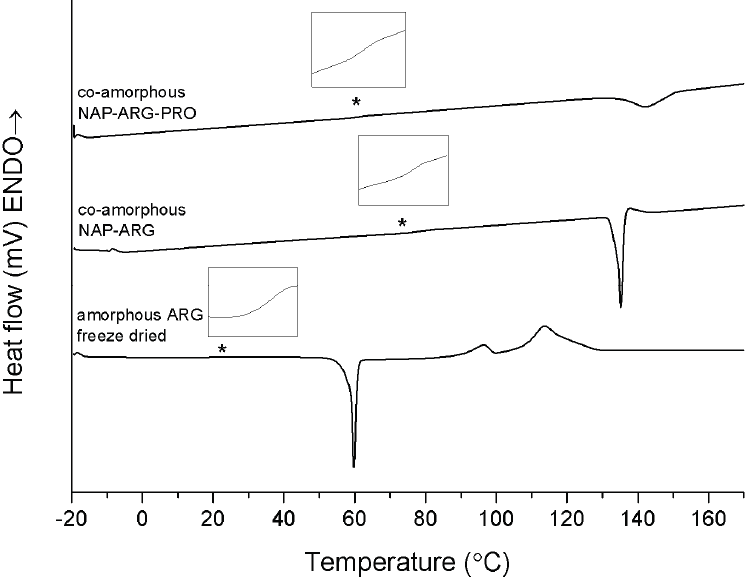
Figure 4. DSC thermograms of amorphous freeze-dried ARG, co-amorphous NAP–ARG and NAP–ARG–PRO. The T is marked by asterisk ( * ) and enlarged in the insert above g the graph. Endothermal events